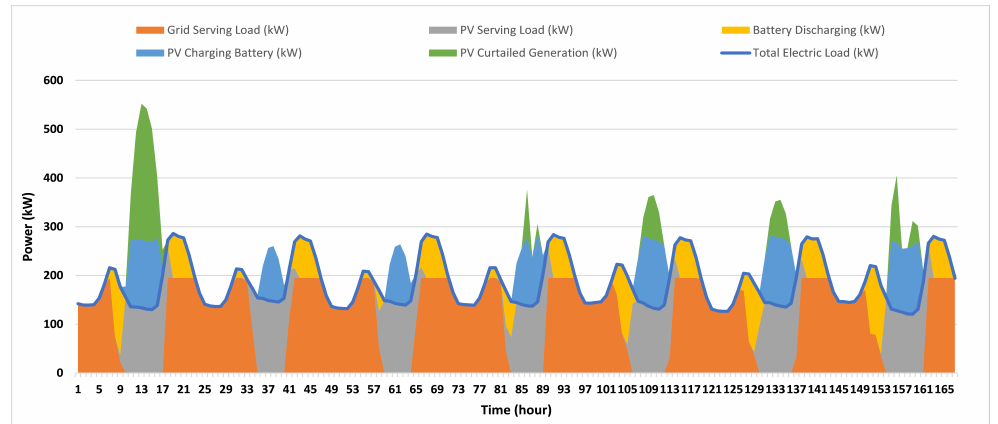
Figure 16. Microgrid operation during a week in the dry season: Case 3, Scenario